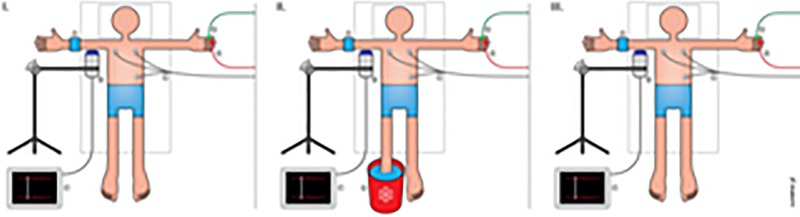
The experimental setup.I: Illustration of the experimental setup with probes attached to the upper extremites. I-II-III: A, a distal occlusion cuff attached to the lower right arm; B, an Ultrasound Doppler probe connected to a ultrasound machine; C, a three-lead ECG; D, a Laser Doppler flux probe; E, a Finometer probe; F, an ultrasound machine; G, an ice water bucket. Illustration: Øystein H. Horgmo, University of Oslo.